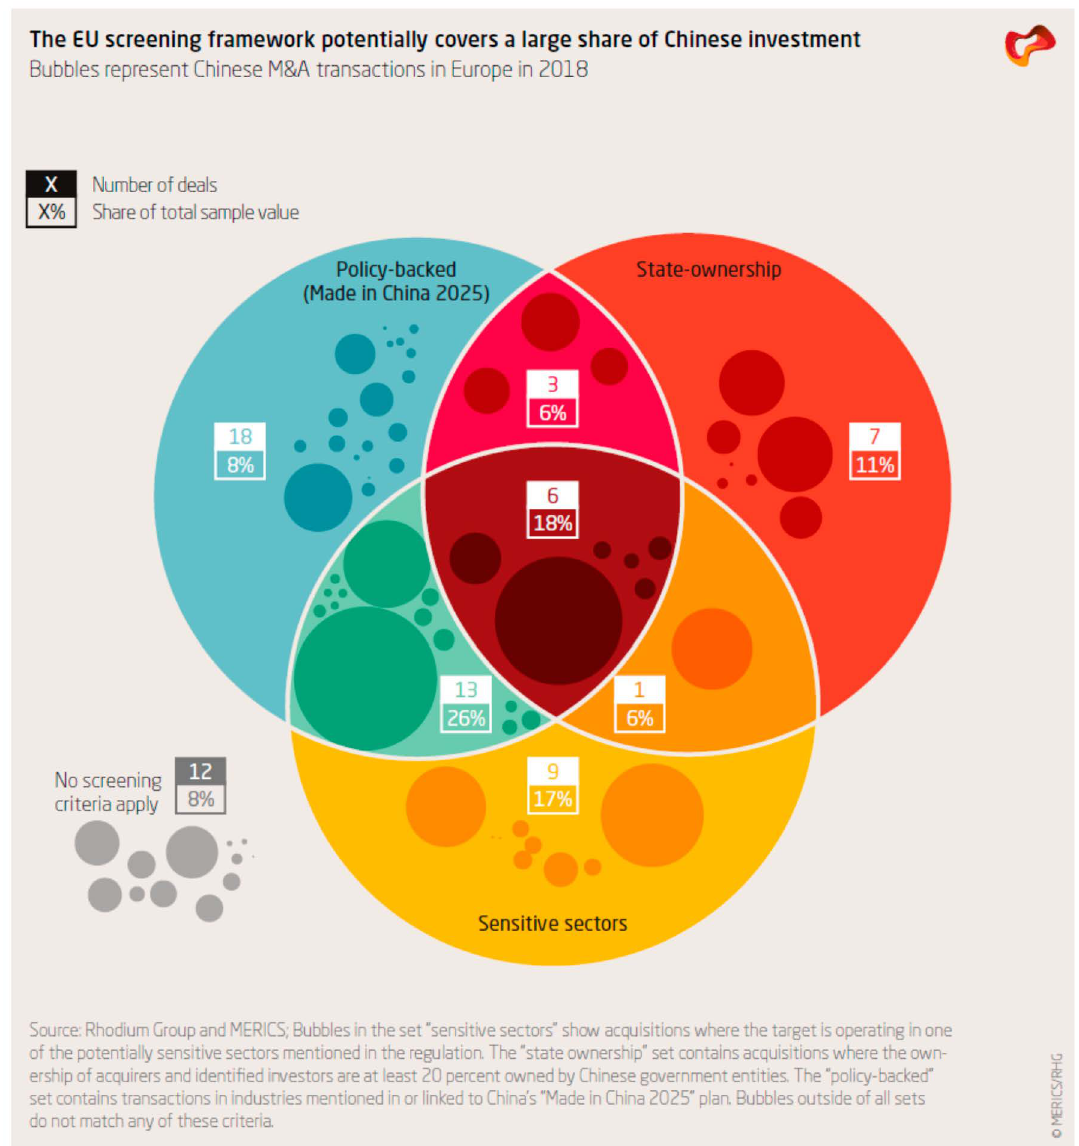
Potential application of the new FDI screening mechanism to Chinese merger and acquisition (M&A) activities in Europe (2018). Source: Thilo Hanemann, Mikko Huotari and Agatha Kratz, ‘Chinese FDI in Europe: 2018 Trends and Impact of New Screening Policies’ (2019)